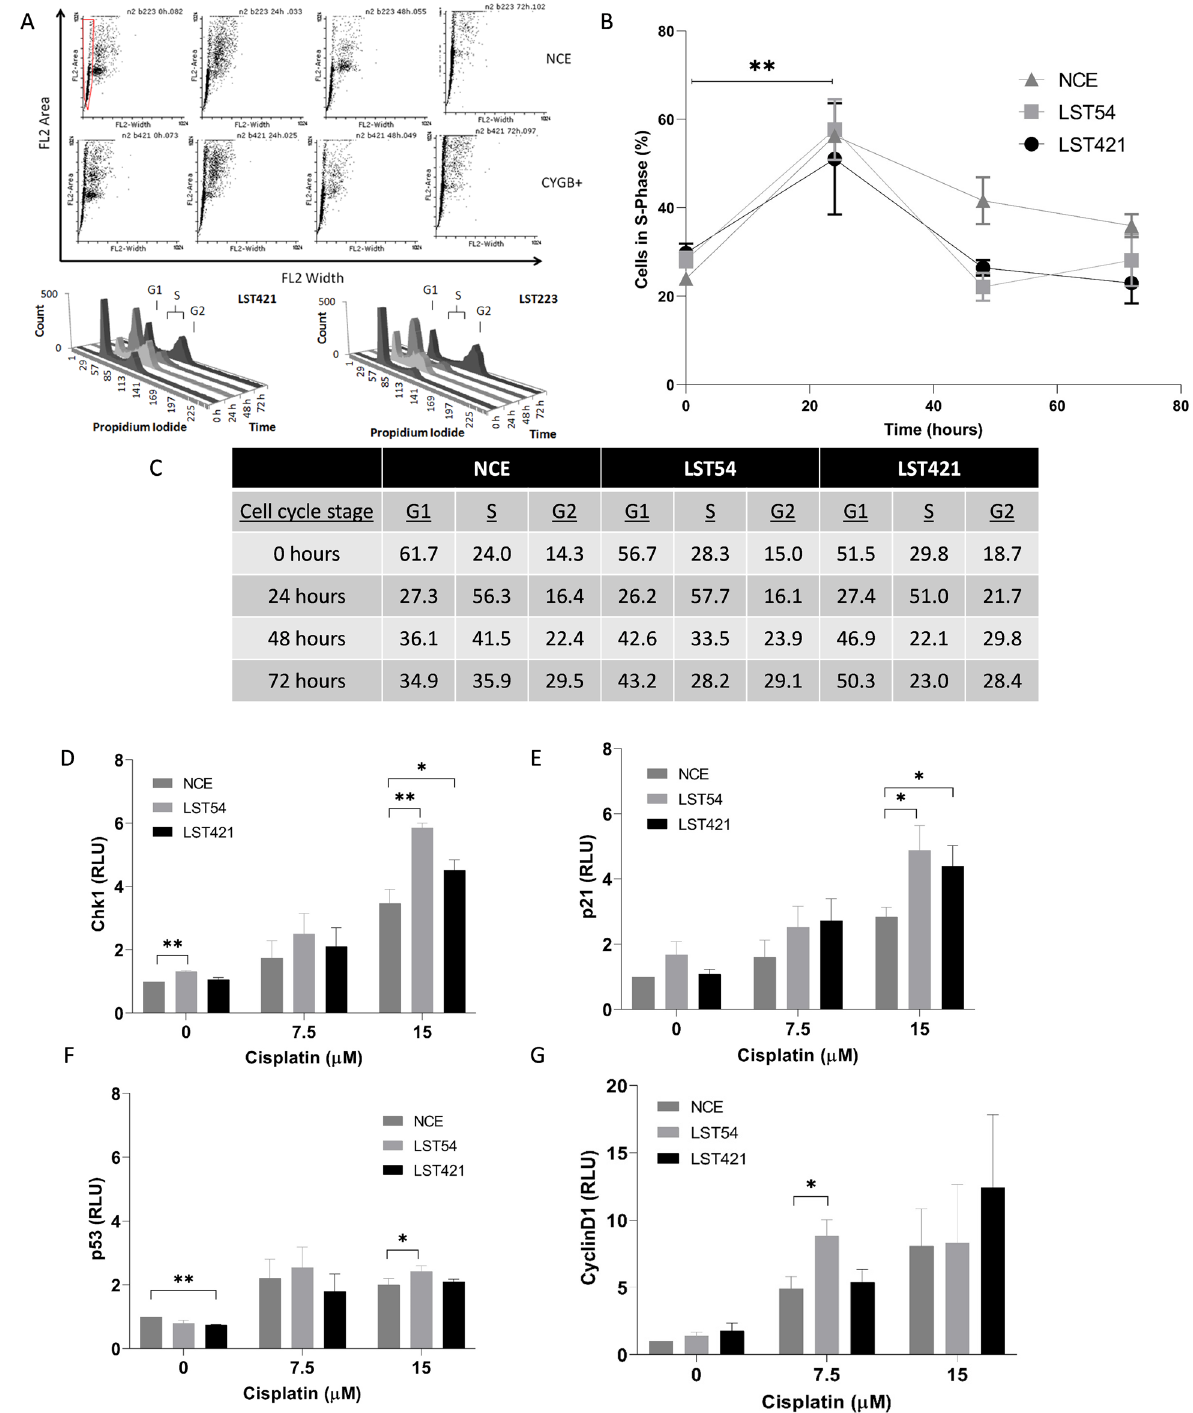
Figure 7. Effect of cisplatin (7.5 µM) treatment on cell cycle as assessed by propidium iodide staining and flow cytometry at 0 h, 24 h, 48 h and 72 h ( A) distribution of propidium iodide staining among cell population, ( B) changes in percentage of cells in S-Phase, C : percentage of cells in different stages of the cell cycle). Changes in protein expression of DNA damage markers; Chk1 ( D ), p21 ( E ), p53 ( F ), and cyclin D1 ( G ) after cytoglobin expressing and non-cytoglobin expressing cells were treated with cisplatin (7.5 and 15 µM). The results from ( A – C) represent the mean of three experiments carried out in duplicate ± SD (n = 3). The results from ( D – G) represent the mean of three independent experiments (± SD) (n = 3). Data is in normalised relative luminescence units in relation to the untreated NCE control ( D – G ). Statistical significance was assessed using unpaired t -tests with Welsh’s correction. * p < 0.05 and ** p < 0.01 in comparison to the NCE control